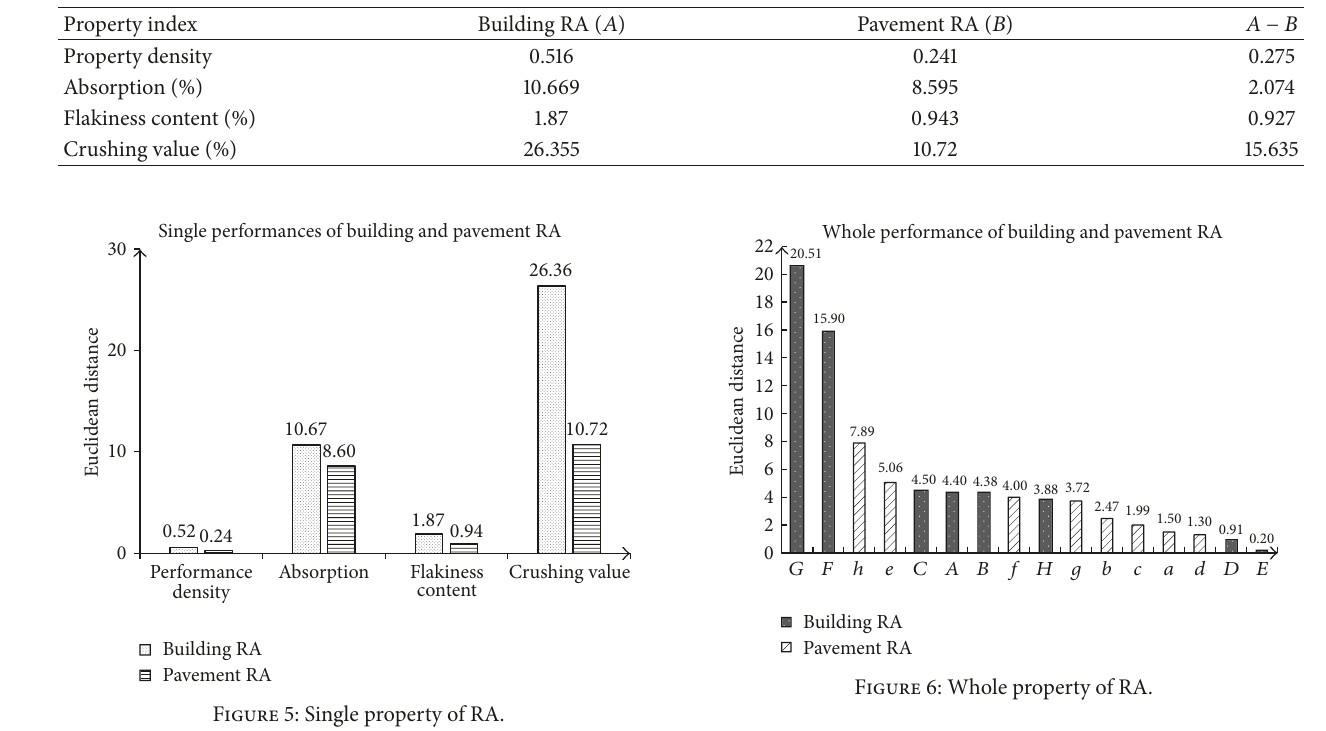
Table 4: Euclidean distance of single property of building and pavement RA.